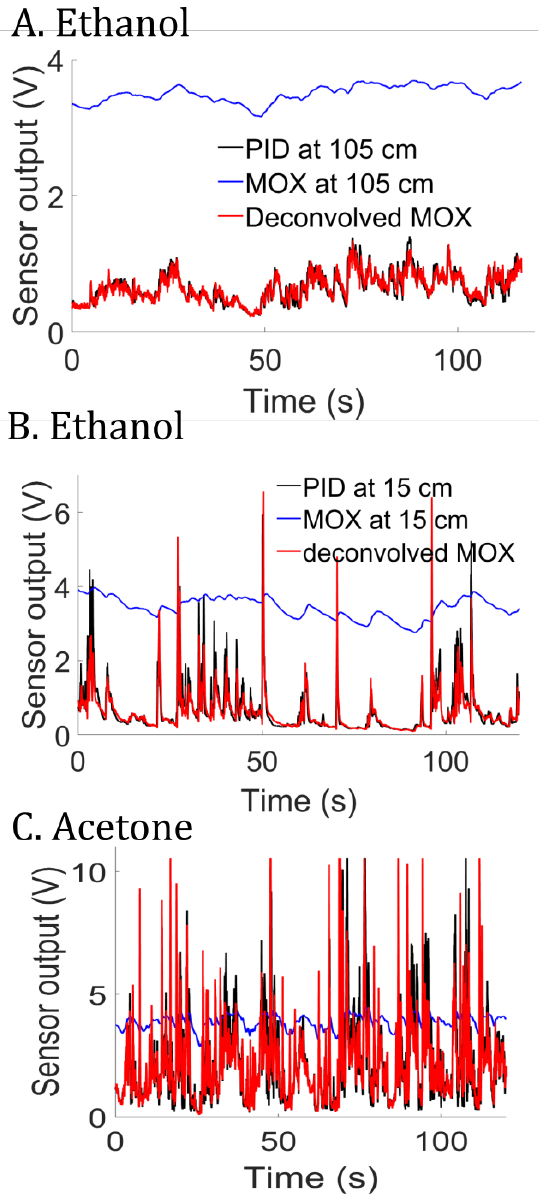
Figure 8. Supervised deconvolution experiments with a real MOX sensor. A Deconvolved MOX at 105 cm from the gas source (ethanol). B Deconvolved MOX at 15 cm from the gas source (ethanol). C Same as in B but with acetone as the gas source.